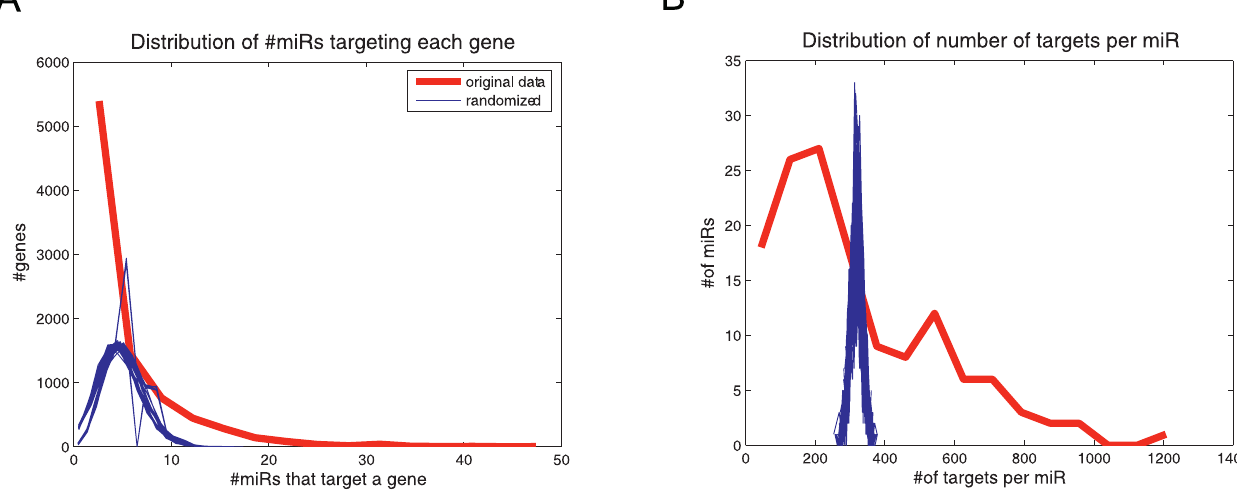
Figure 1. miRs and Target Genes in the TargetScan Dataset (A) Distribution of the number of different miRs regulating each target gene in the TargetScan dataset. The thick red line represents the distribution in the original datasets, while each of the thin blue lines represents the distribution in one of the column-randomized matrices. The matrix contains only genes with at least one predicted site in their 3 9 UTR. In each randomization, we shuffled the assignment of miRs to their targets, keeping constant the number of targets per miR. (B) Distribution of number of targets per miR in the TargetScan dataset. In the thick red line we depicted the original distribution, while each blue thin line represents the distribution in one of the 100 row-randomized matrices, which preserve the distribution of number of miRs targeting each gene.